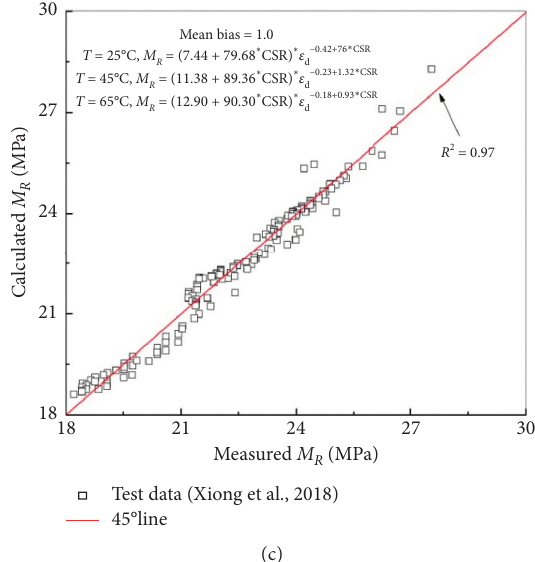
Figure 14: Comparison between calculated value and measured value of M